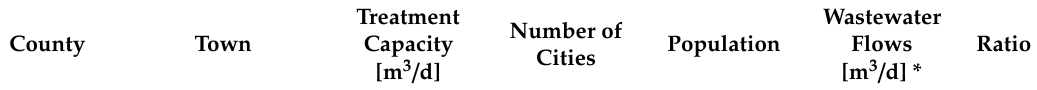
Table 3. Estimation of treated and untreated wastewater flows to calculate reused-water potential (own analysis; wastewater treatment capacities according to the Ministry of Ecology and Environment of the People’s Republic of China